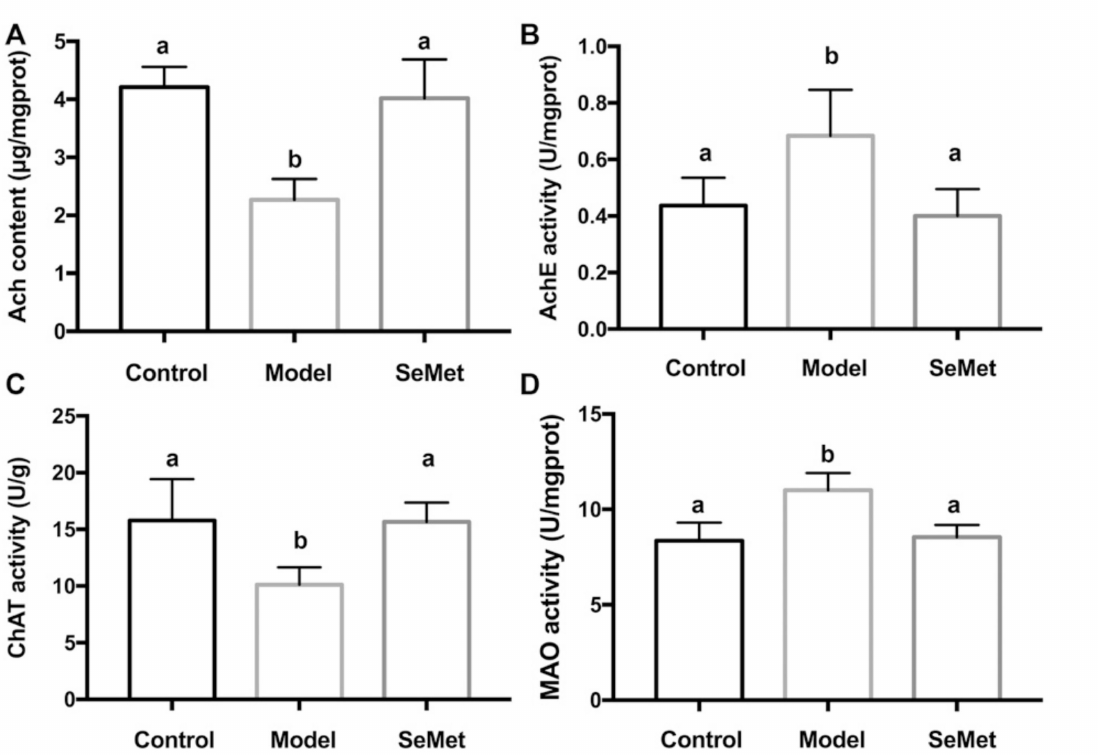
Figure 2. Effects of SeMet on ( A ) the acetylcholine (Ach) level, ( B ) acetyl cholinesterase (AChE) activity, ( C ) choline acetyltransferase (ChAT) activity, and ( D ) monoamine oxidase (MAO) activity in hippocampus. The same letter within each column indicates no significant difference ( p >